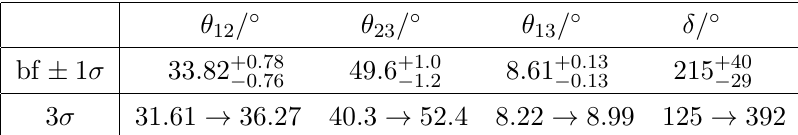
Table 1 . Best-(cid:12)t, 1 (cid:27) and 3 (cid:27) ranges of three mixing angles and the Dirac CP phase (cid:14) for NMO (NuFIT